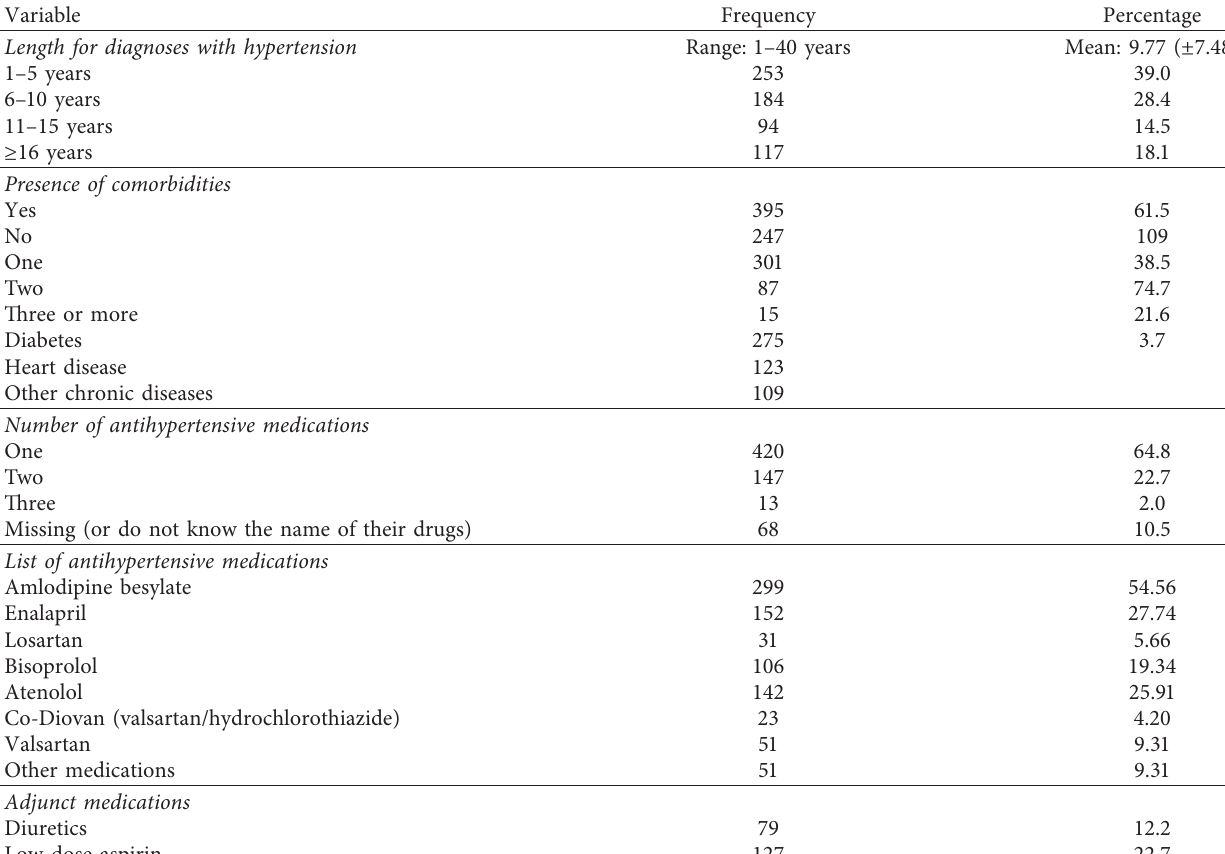
Table 2: Medical history of participants.